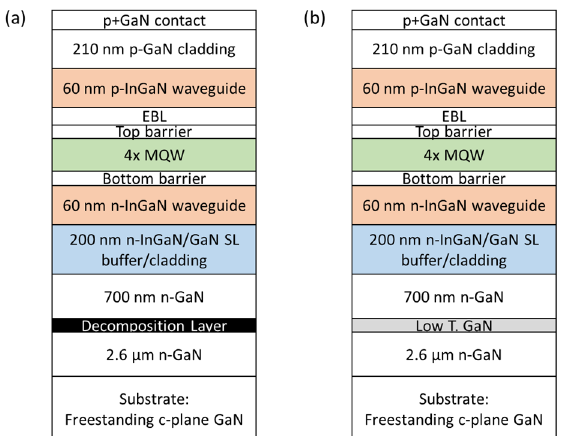
Figure 1. Schematic epi structure of ( a ) laser diodes on a strain-relaxed template (SRT) and ( b ) reference laser diodes. Instead of a decomposition layer, a low-temperature GaN was grown in reference LDs, while all other layers were kept the same.